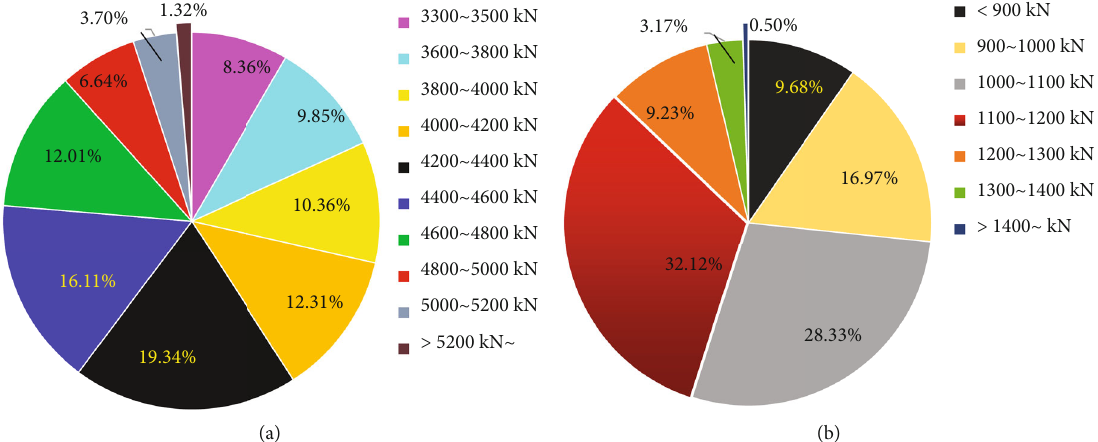
Figure 8: Actual distribution of the working resistance of the PP support. (a) Distribution of the maximum working resistance. (b) Distribution of the maximum pressure of pillar.